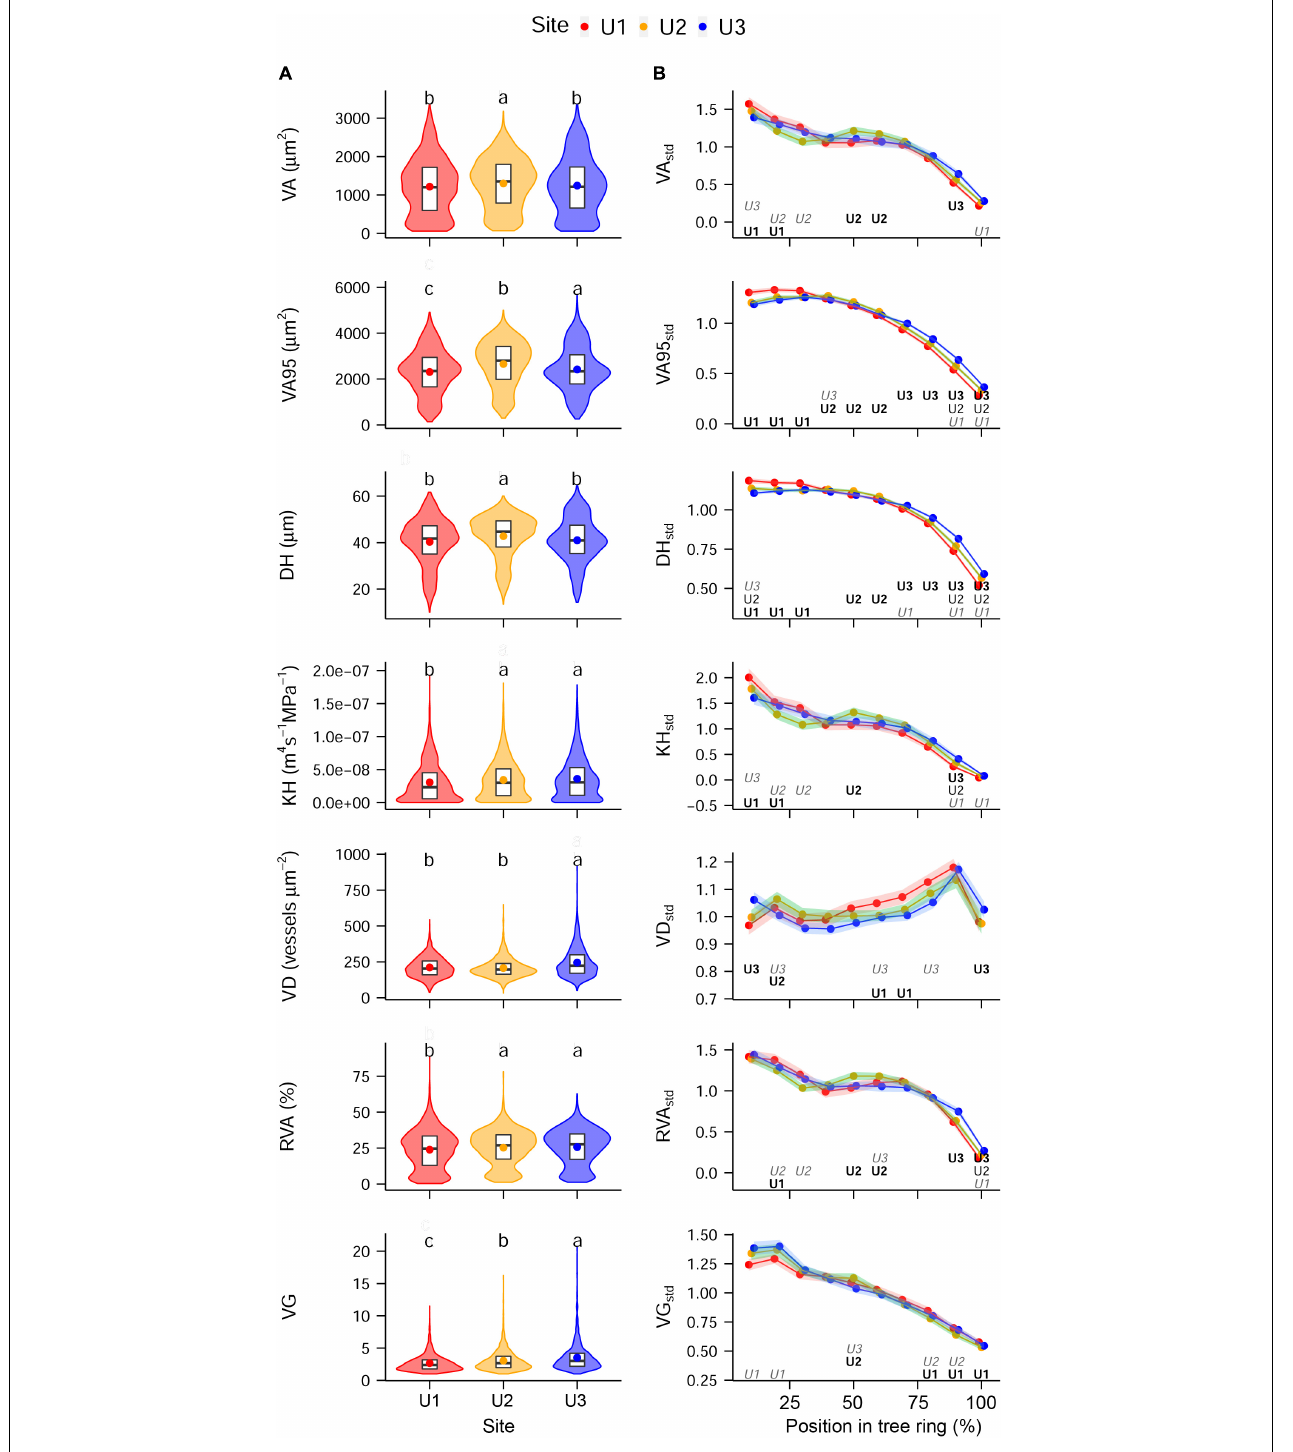
FIGURE 3 | (A) Absolute inter-annual and (B) standardized intra-annual values of each of the anatomical traits studied at the different study sites: U1—1,200 m a.s.l., U2—1,600 m a.s.l., and U3—1,950 m a.s.l. Panel (A) shows violin plots, with boxplots (1st, 2nd, and 3rd quartiles) and mean values (dots); letters indicate significant differences between sites (permutation test of independence, P -value < 0.05). Panel (B) shows mean values (dots) and 95% CI (shaded area); letters indicate if values are significantly higher ( bold ), lower ( italics gray ), or if they are significantly different at all sites (regular format indicates the middle value). If both bold and italics gray are shown, this means that the mid-value was the only one that did not differ significantly. Permutation test of independence, P -value < 0.05. For the anatomical trait abbreviations, see Figure 2 .